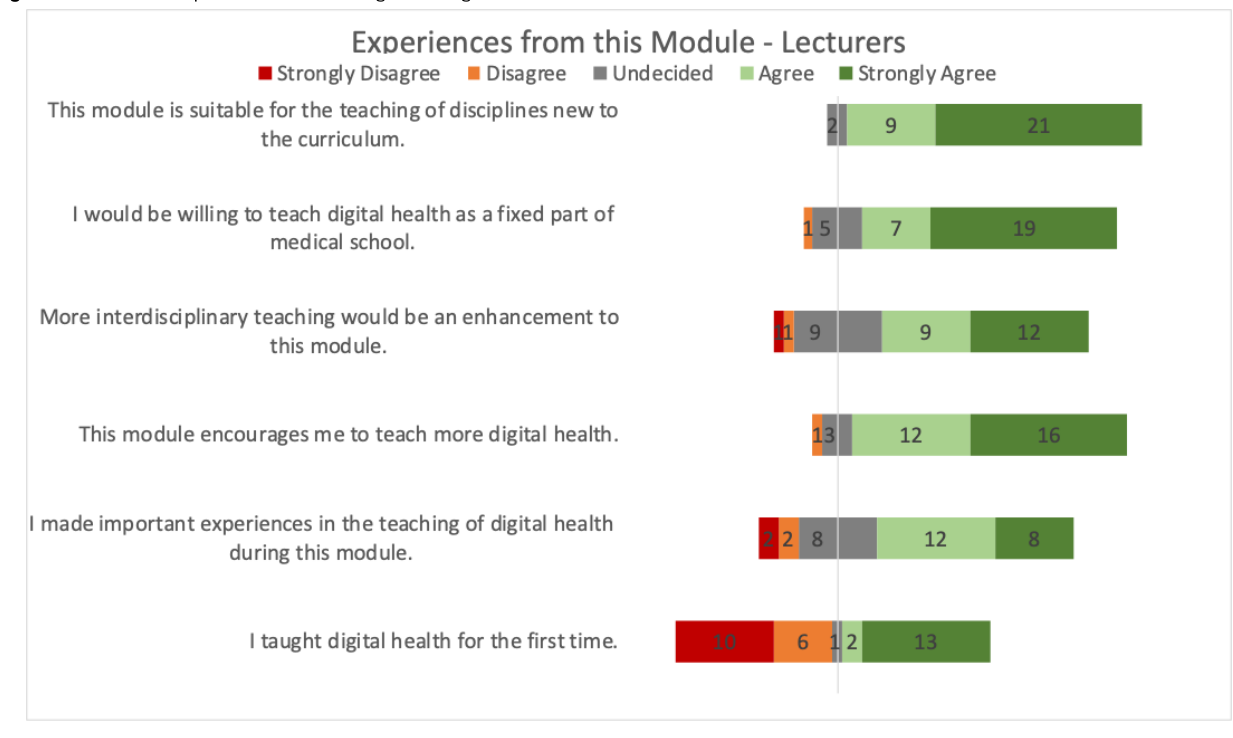
Figure 5. Lecturers’experience with teaching in the digital health